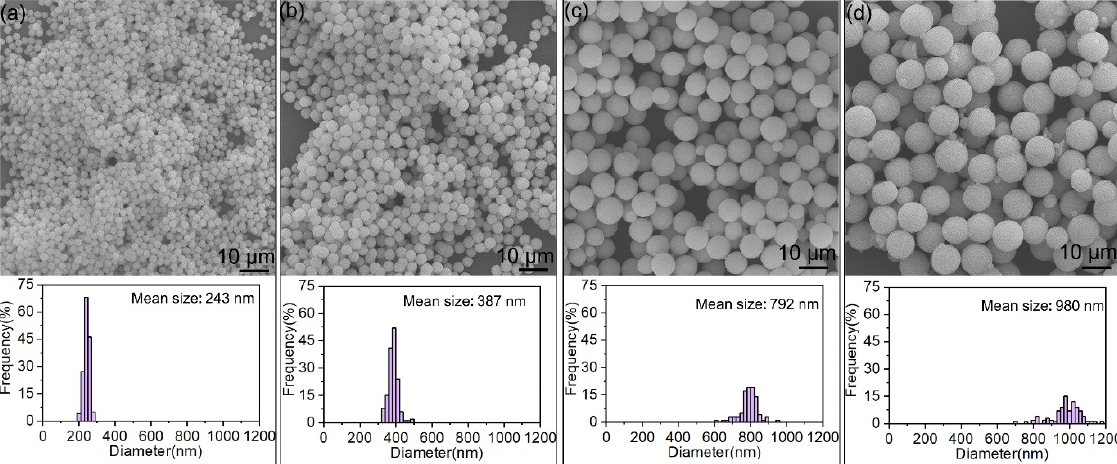
Figure 3. SEM images and size distribution of spherical Y 2 O 3 powders: ( a ) 243 nm; ( b ) 387 nm; ( c ) 792 nm; ( d ) 980 nm.